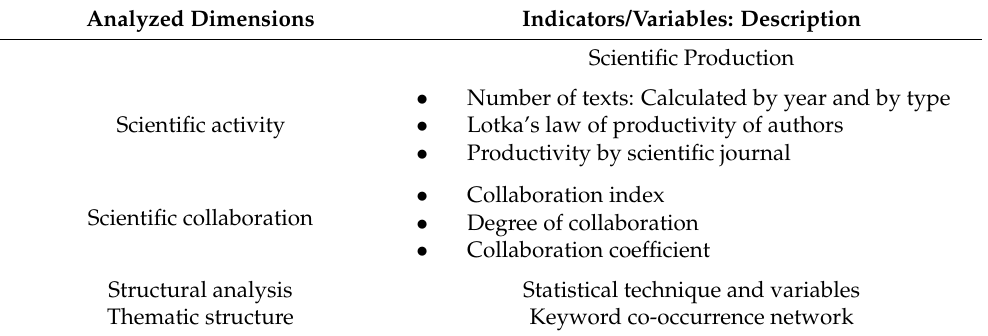
Table 4. Description of bibliometric indicators and analysis